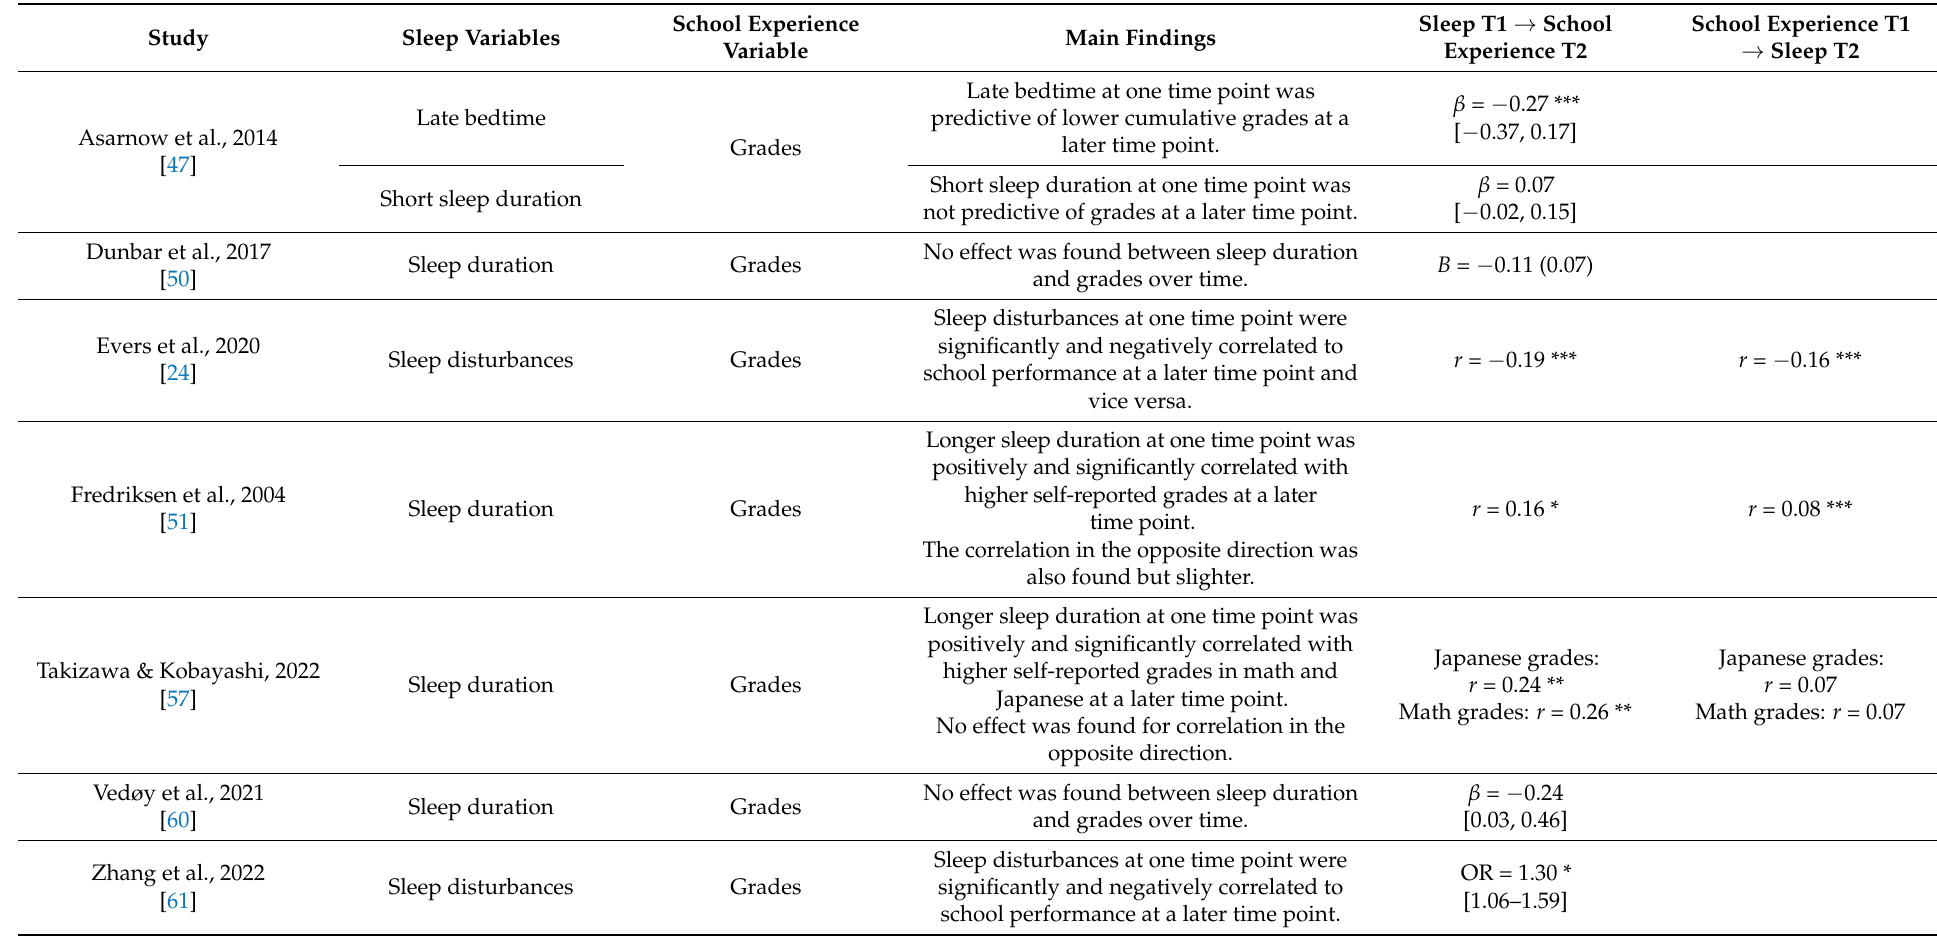
Table 3. Longitudinal associations between sleep and school